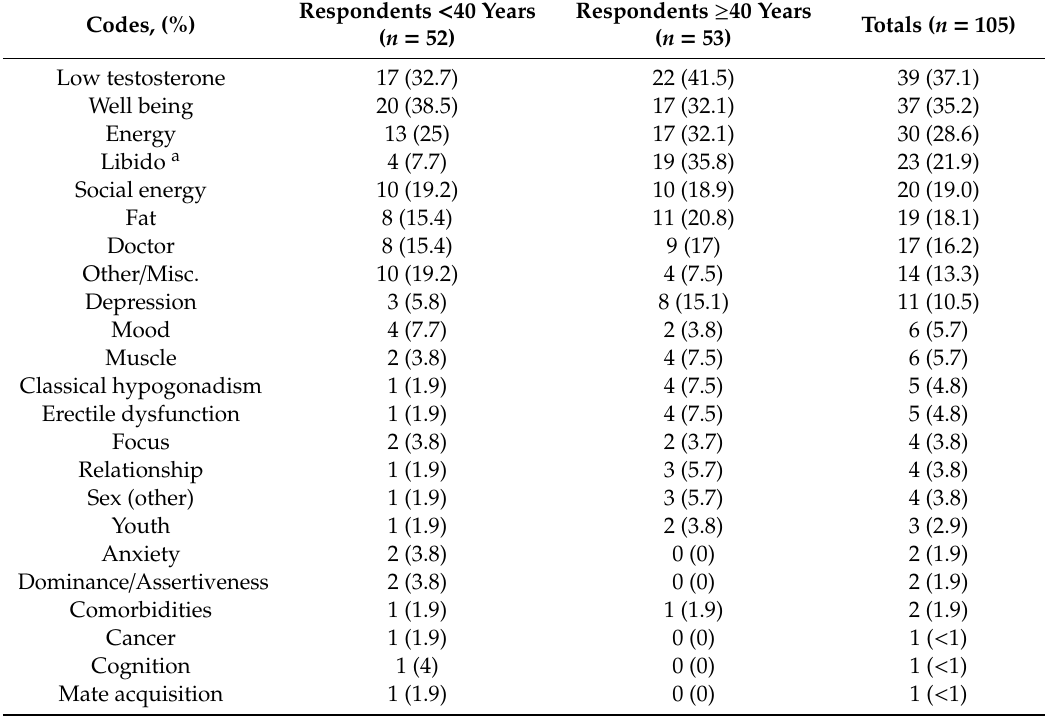
Table 4. Frequency of coding themes related to why men sought